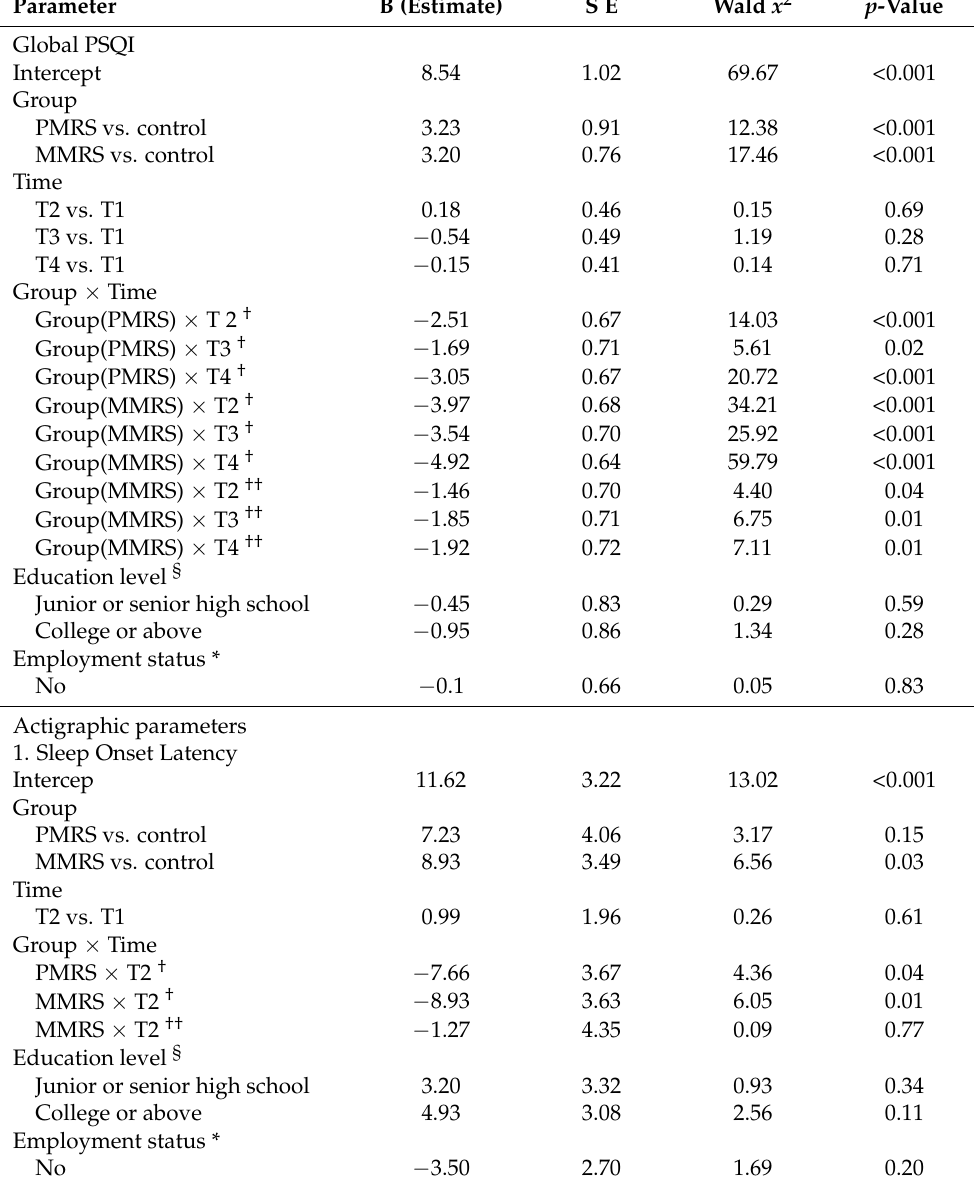
Table 5. The effects of intervention on subjective and objective sleep parameters of participants.